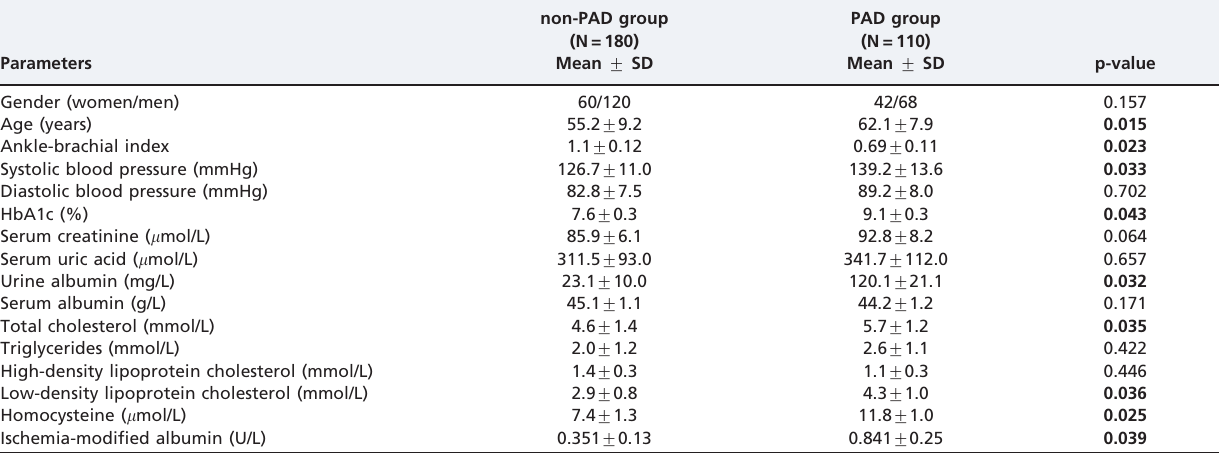
Table 1 - Clinical parameters of non-PAD and PAD groups with T2DM.